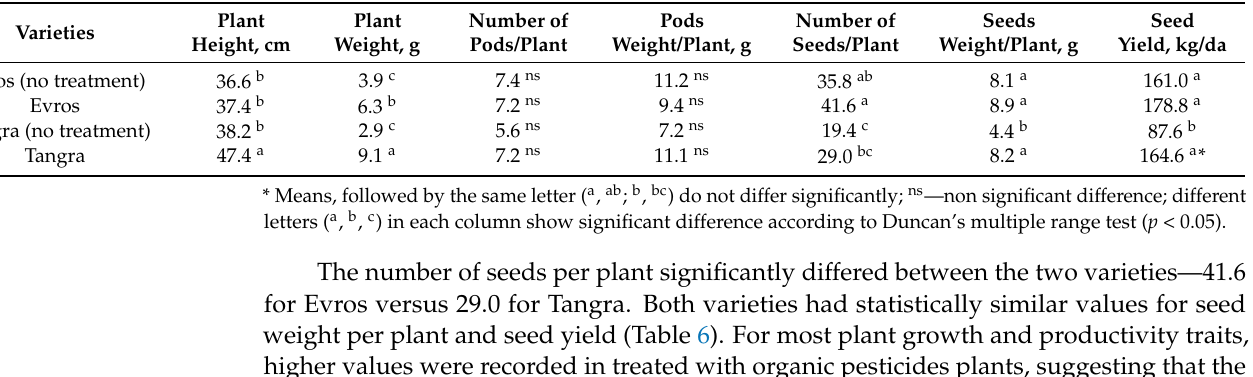
Table 6. Biometric measurements of green bean varieties grown in organic field at botanical maturity (fully ripe stage when beans are